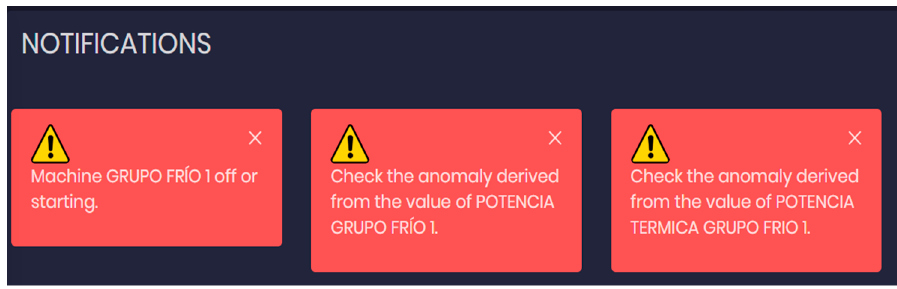
Figure 11. An example of the diagnosis.